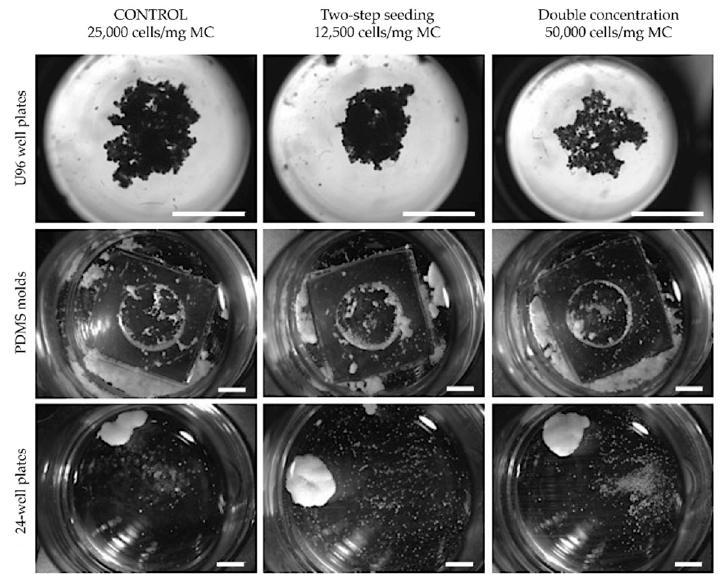
Figure 2. Microtissues (MT) fabrication and optimization under static conditions. Static cell-seeding in U96 well plates, polydimethylsiloxane (PDMS) molds, and 24-well plates at different cell/MC ratios, scale bars: U96 conditions = 3 mm; PDMS molds and 24 well plates = 2 mm.